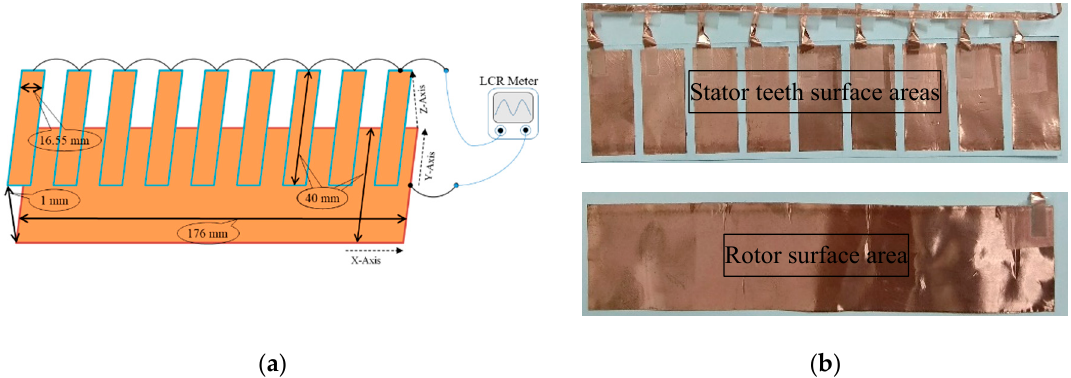
Figure 4. Experimental scheme to measure C sr . ( a ) Diagram of the experimental scheme. ( b ) Thin copper tape was used to represent capacitance surfaces. Table 1. Motor parasitic capacitances